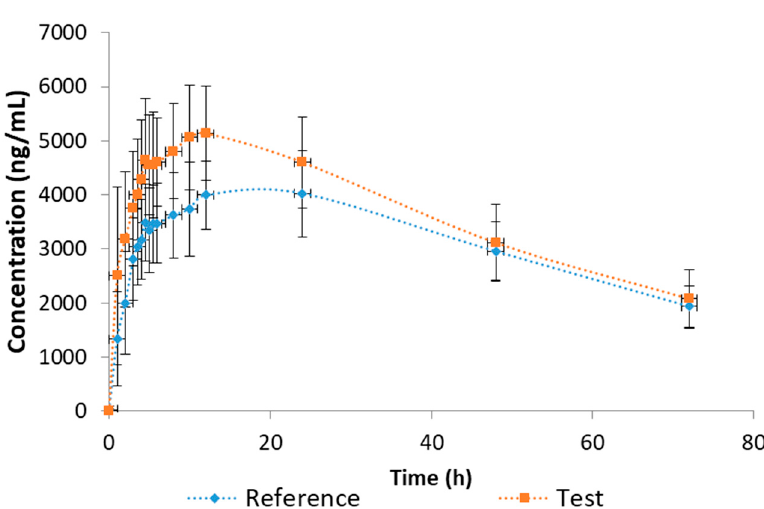
Figure A1 . Individual CBZ plasma levels of the reference and test formulations.